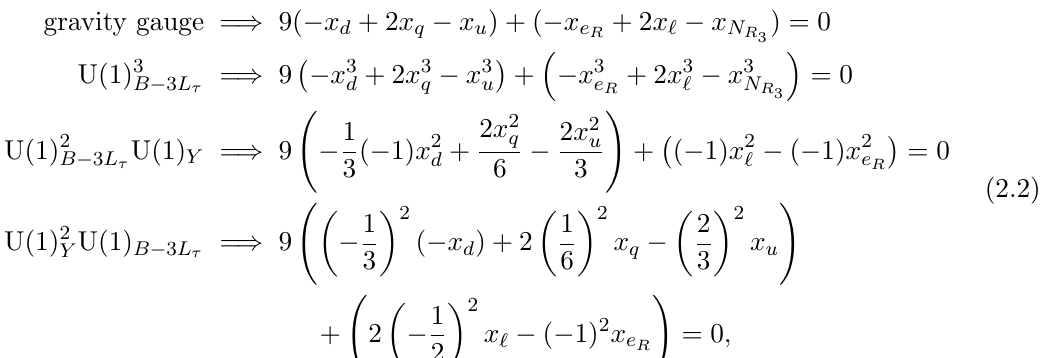
Table 1 . Relevant particle content of the model and their charges under SM (cid:2) U(1) B (cid:0) 3 L following non-trivial